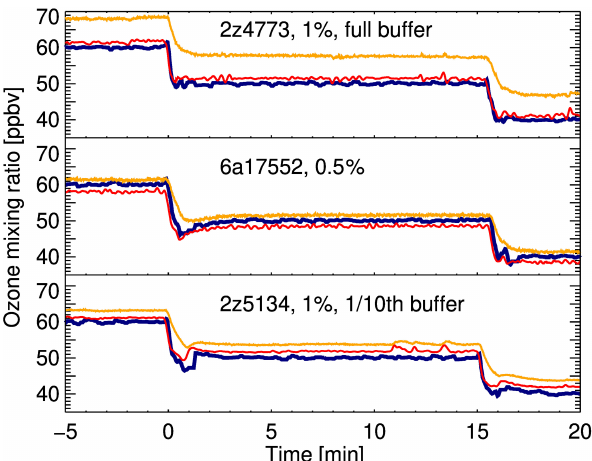
Figure 2. Response of three ECC sondes using three different solu- tions during two plateau changes. The color-coding is the same as in Fig. 1. The reference time is defined as the time when the TEI 49C drops below 59ppb during the first change in plateaus.